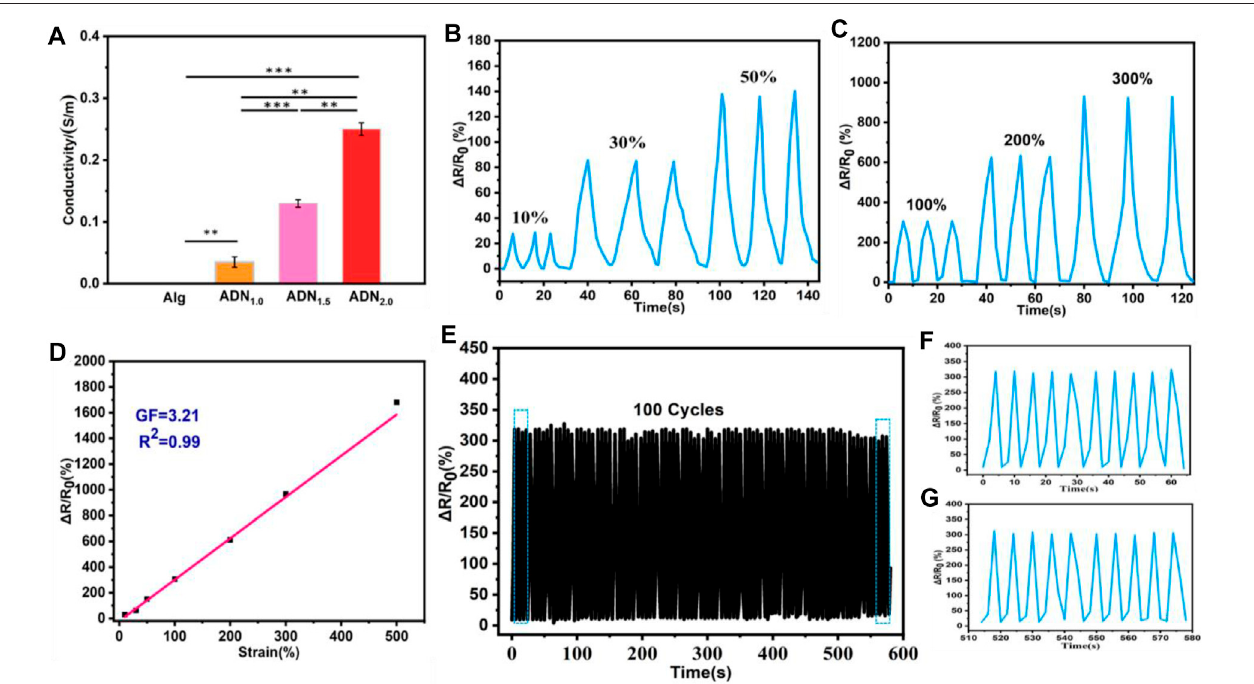
FIGURE 6 | Electromechanical performances of the ADN 1.5 hydrogel applicated as fl exible strain sensor. (A) Conductivity comparison of hydrogels. The cyclic relative resistance changes of this hydrogel strain sensor under low strains (B) and high strains (C) , respectively. (D) The linear fi tting of the relationship between the relative resistance changes and the strain of this hydrogel sensor. (E) The durability test of the hydrogel sensor under 0 – 100% strain. (F) Magni fi ed signal during 1 – 10 cycles. (G) Magni fi ed signal during 91 – 100